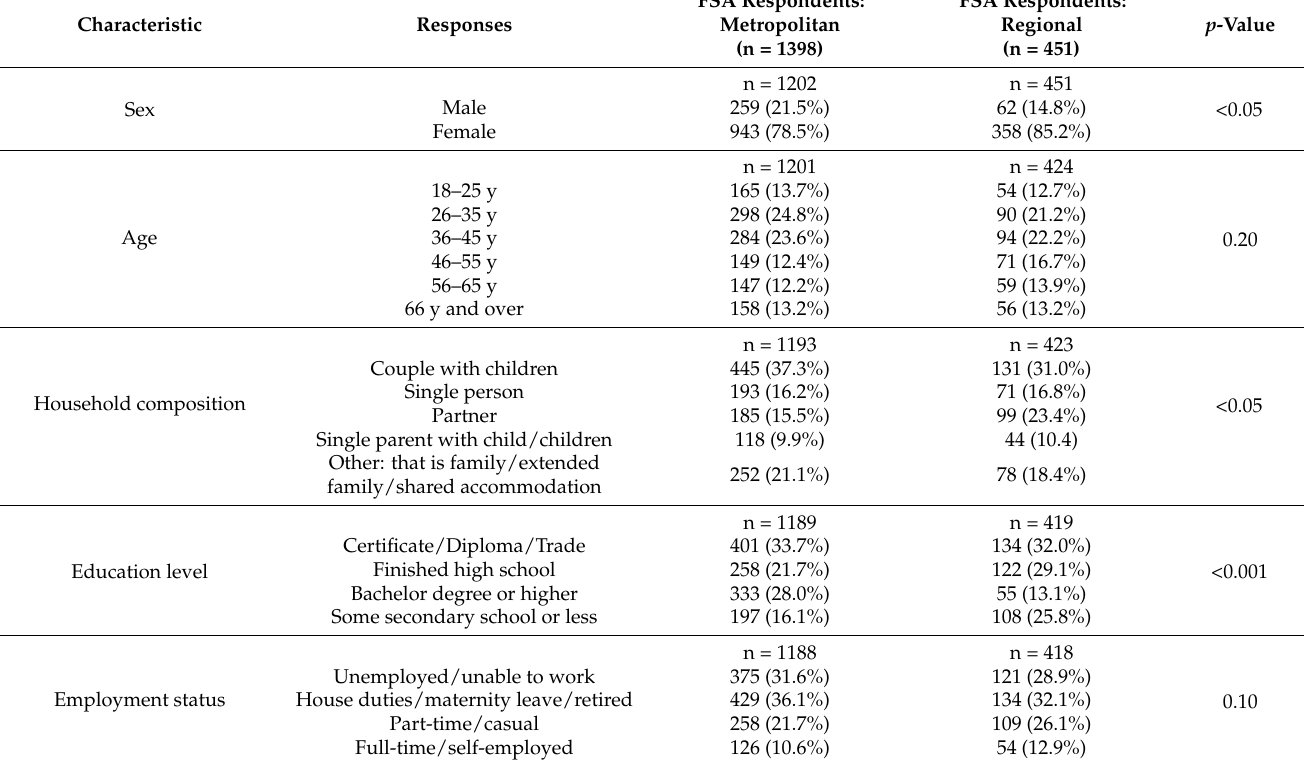
Table 1. Demographic characteristics of participants from metropolitan and regional